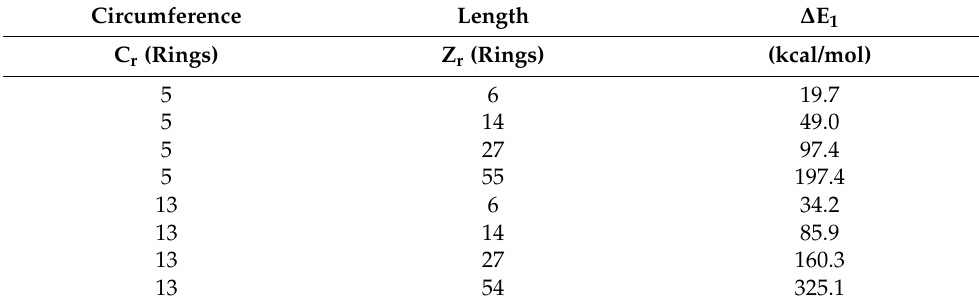
Table 2. Pair binding energy ∆ E 1 (kcal/mol) as function of CNT circumference, C r , in rings and length, Z r , in